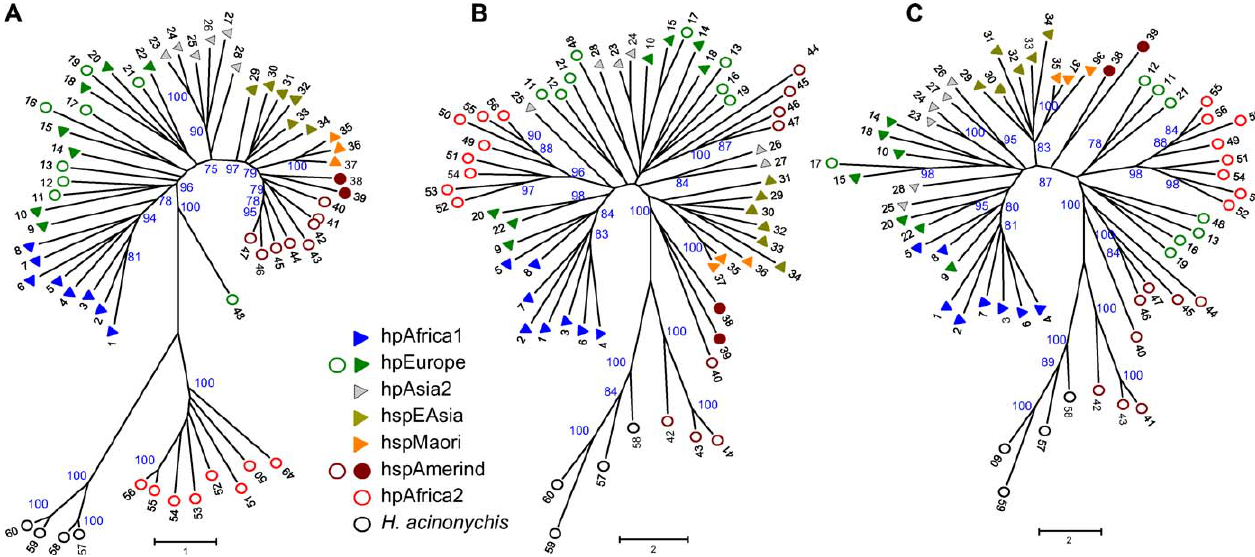
Figure 4. Phylogenetic Structure (Neighbor-Joining Trees) According to (A) Sequences of Seven Core Genes, (B) Microarray Data Excluding cag PAI, and (C) Microarray Data Including the cag PAI for 56 Strains of H. pylori and Four Strains of H. acinonychis Filled triangles indicate strains possessing the cag PAI, open circles indicate strains lacking it, and filled circles indicate hspAmerind strains that lack HP0536–0548 from the cag PAI. Colors indicate population assignments by Structure based on the sequence data (B. Linz, unpublished data). Numbers at the tips of the twigs are strain numbers (Table S3), while blue numbers next to nodes are bootstrap values over 75% after 250 iterations. DOI: 10.1371/journal.pgen.0010043.g004